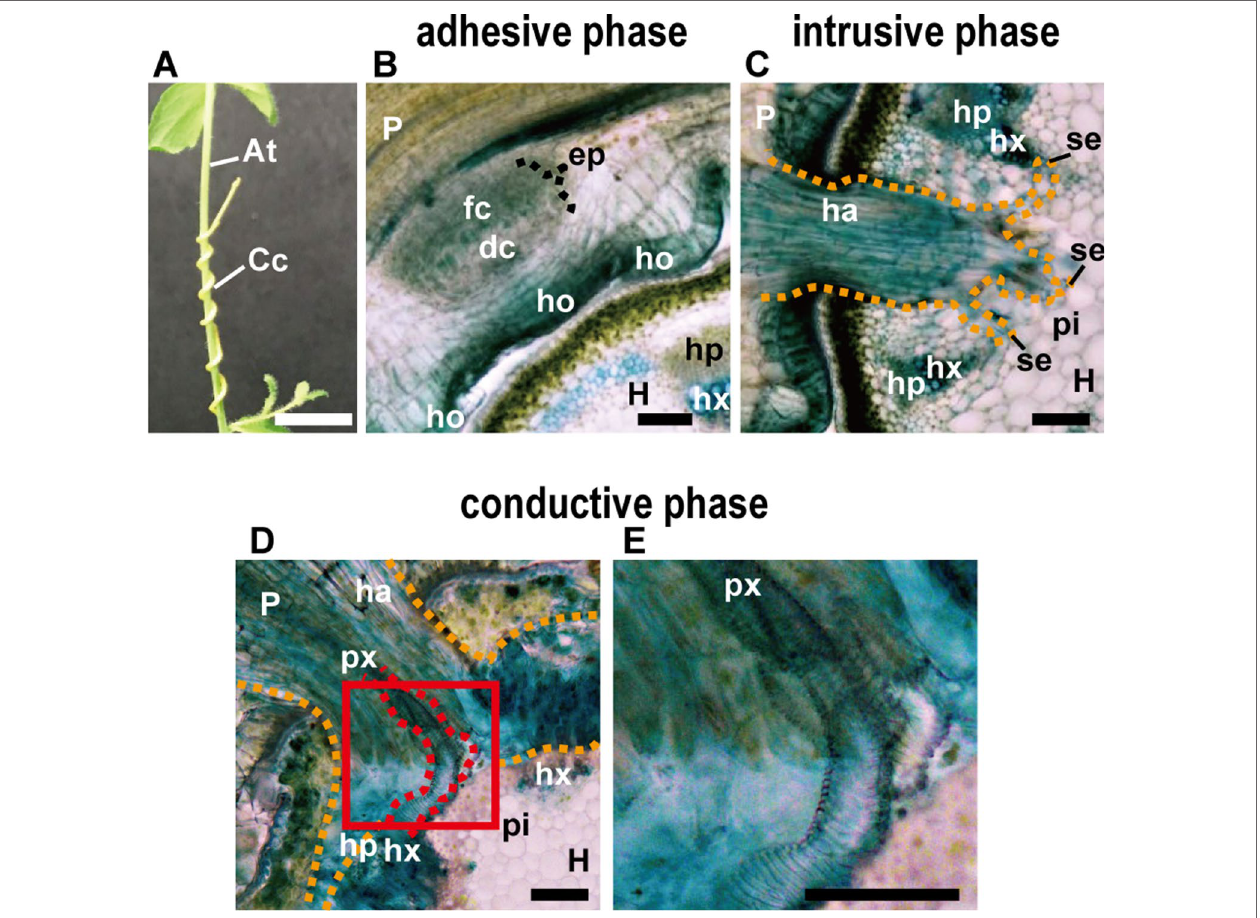
FIGURe 1 | (A) Appearance of parasitic site formed between Cuscuta campestris (Cc) and Arabidopsis thaliana (At) from the outside. C. campestris coils around the inflorescence stem of Arabidopsis. Scale bar, 1 cm. (B–e) Transverse sections of the three phases of parasitic processes of Cuscuta . Scale bars, 200 μm. (B) Adhesive phase. Holdfast (ho) is formed on the host-attaching surface of C. campestris . Prehaustorium develops in the inner cortex of the stem right behind holdfast. In the endophyte primordium (ep), digitate cells (dc) and file cells (fc) differentiate and start to elongate. (C) Intrusive phase. Haustorium (ha) intrudes in the cortex of the host stem. It sometimes reaches to the pith (pi). (D) Conductive phase. (e) Area in the red square in (D) is magnified. Vascular conductive elements (px) are formed in the haustorim. P, parasite; H, host; ha, haustorium; hp, host phloem; hx, host xylem; px, parasite xylem; pi, pith; se, searching hypha; orange dotted line, outline of haustorium; red dotted line, outline of parasite xylem. In all panels, 200-μm-thick micro-slicer sections were stained with toluidine blue.